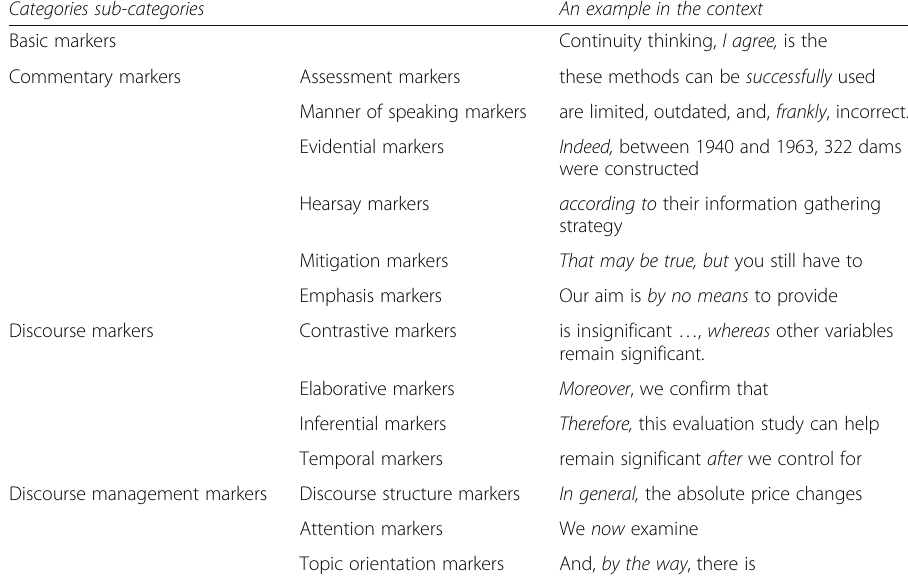
Table 4 A Meta-synthesized Framework of Pragmatic Markers Categories